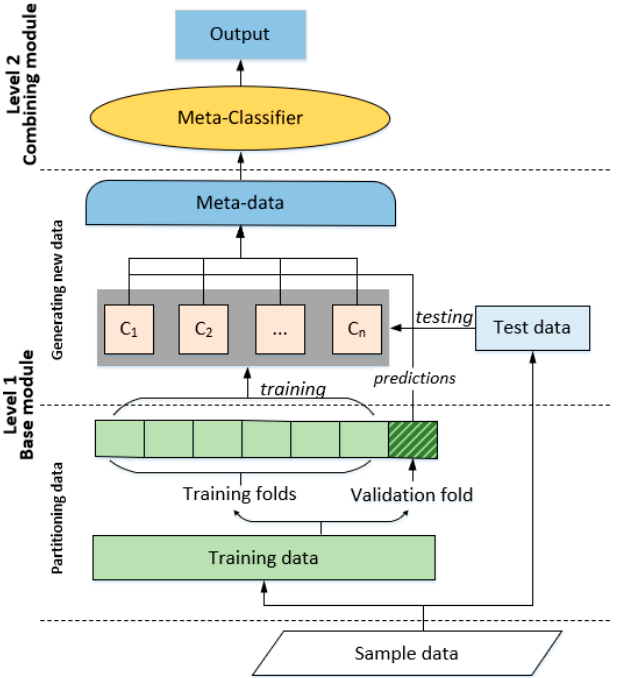
Figure 2. Heterogeneous stacking-based ensemble learning framework.